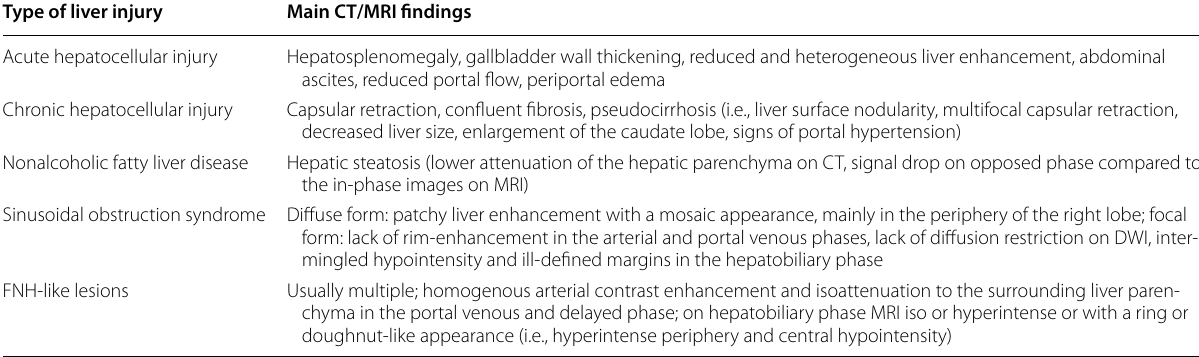
Table 3 Most common ChT-induced parenchymal and vascular hepatic changes Type of liver injury